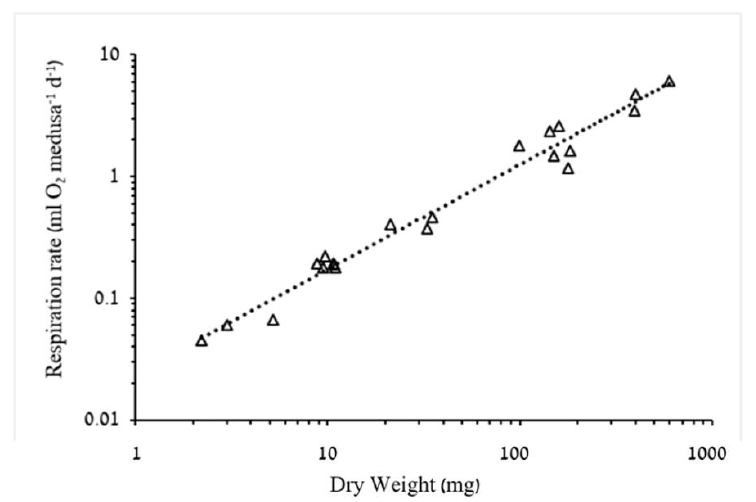
Figure 4. Log–log plots of the relationship between dry weight (DW) and respiration rate (RR) ( n